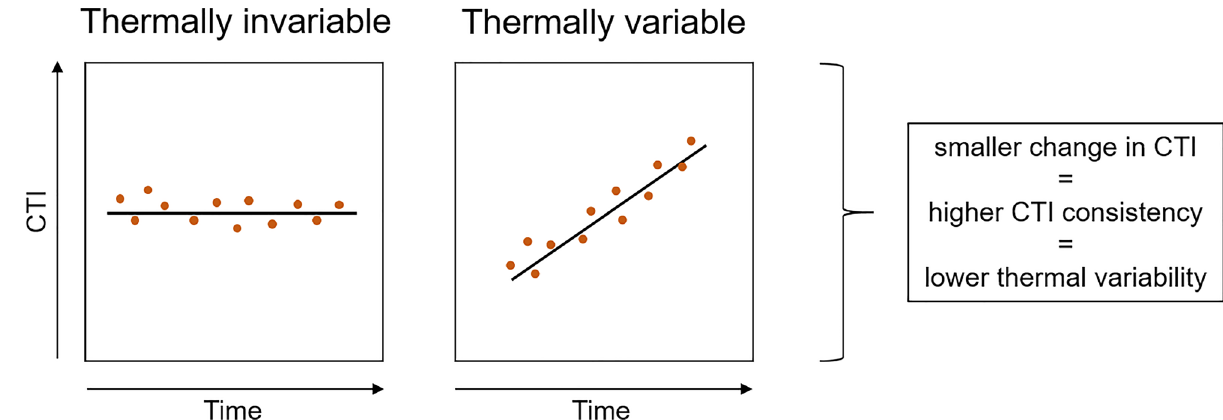
Figure 1. Graphical illustration of the concept of thermal variability. The coloured circles represent values of hypothetical community-level properties (here, community temperature index CTI) over time. The communities are less thermally variable if there is no clear long-term trend in the community property and more thermally variable if there is a clear long-term trend in the community property.